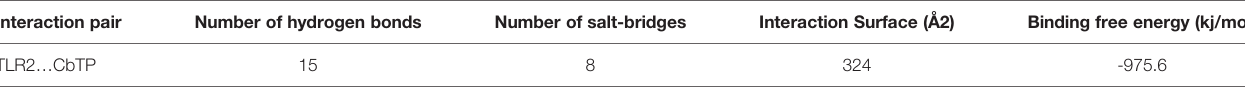
TABLE 3 | Key interaction parameters between CbTP and